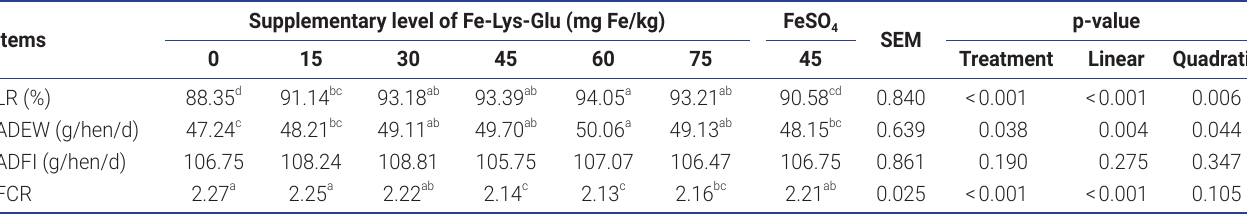
Table 2. Effects of dietary Fe-Lys-Glu supplementation on performance of laying hens